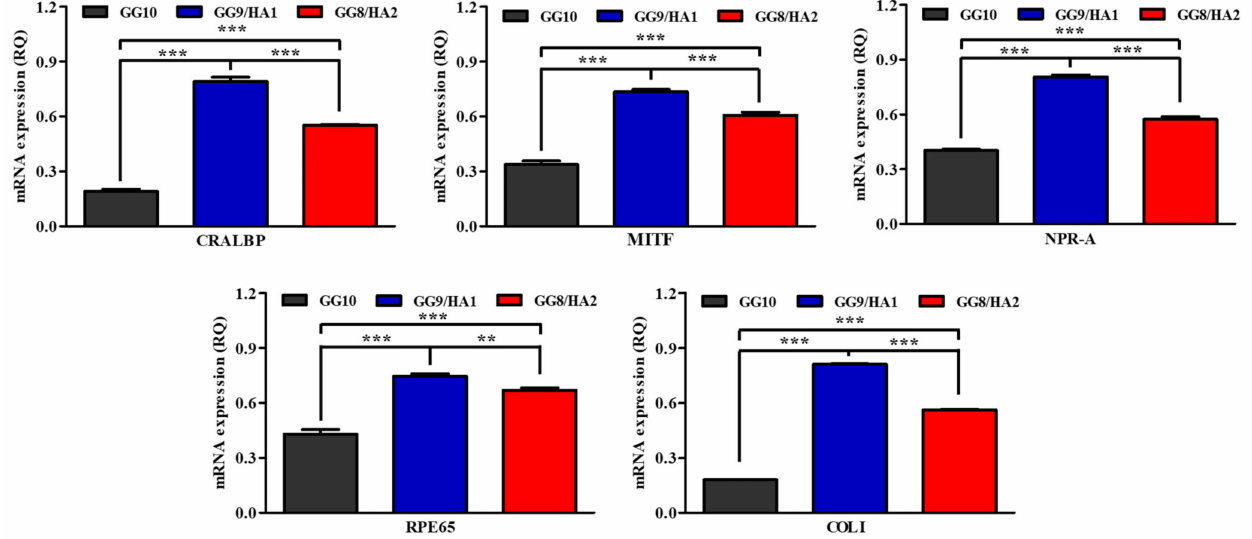
Figure 8. RPE-specific gene expression evaluated by RT-PCR with CRALBP, MITF, RPE65m NPR-A, and COL1 normalized by GAPDH (values are mean ± SD, n = 6, p < 0.01 (**), p < 0.001